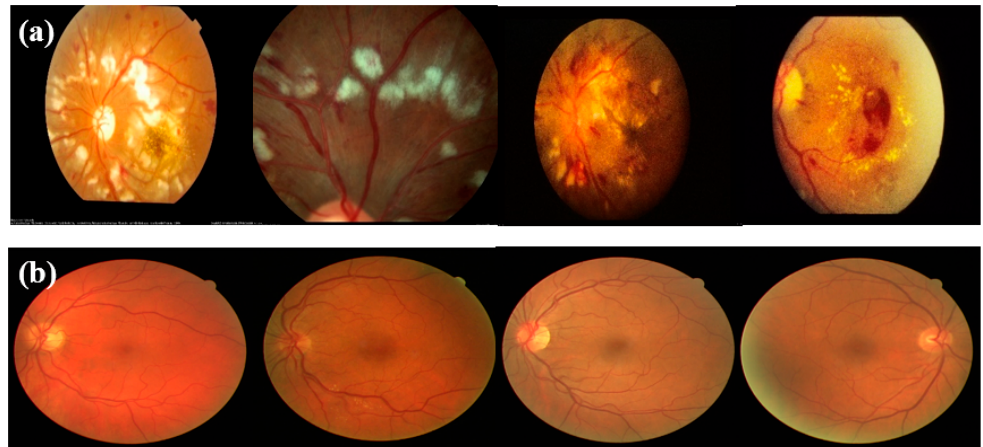
Figure 10. Output example of the CAD system ( a ) signifies HR instances, and ( b ) illustrates non-HR retinography instances. Table 6. Assessment of the efficiency of the developed CAD-HR system vs other deep learning systems on 9500